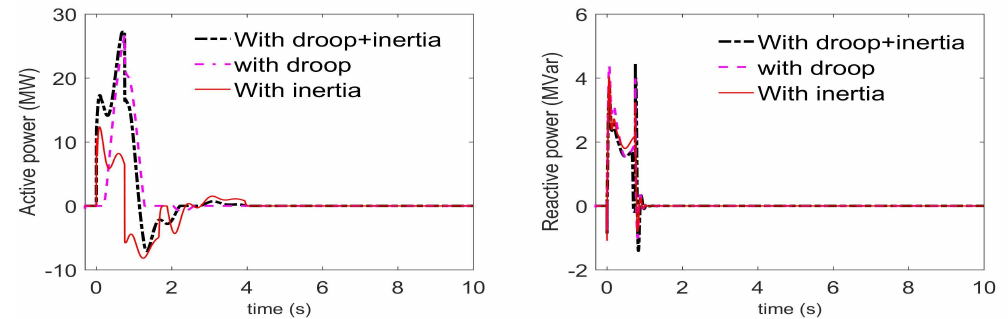
Figure 9. The active and reactive power of BESS with the load